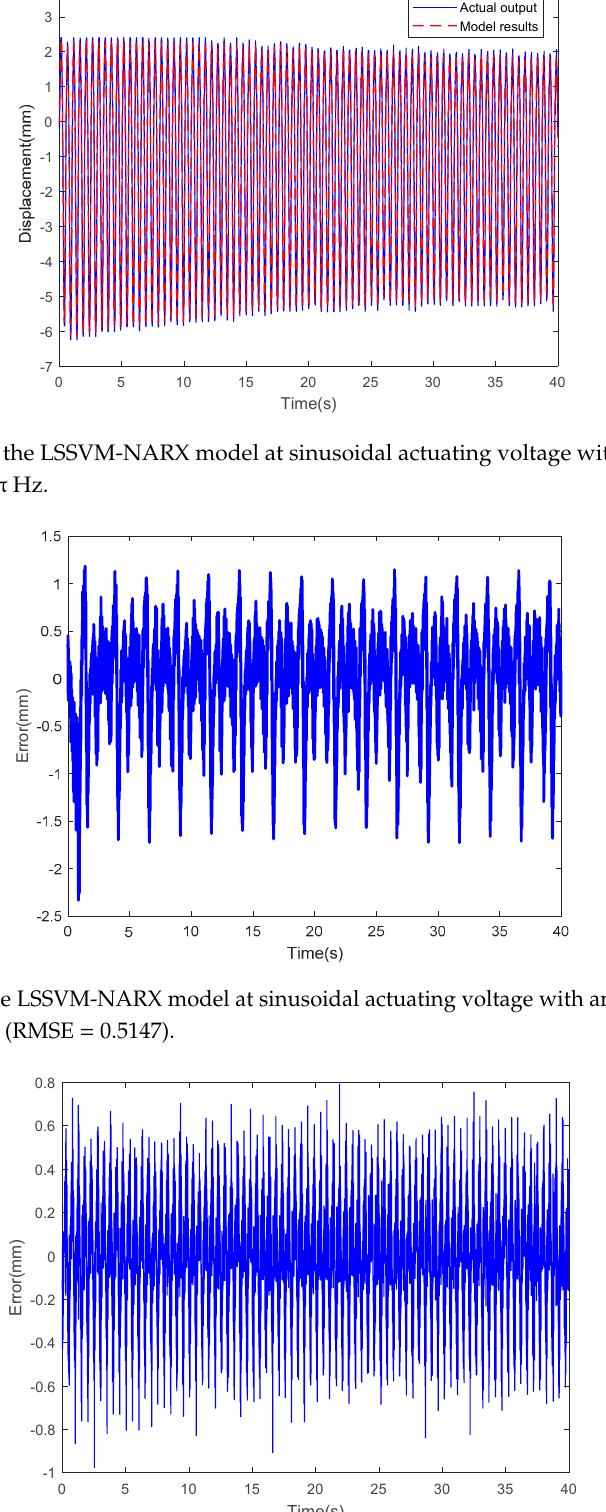
Figure 24. Error of the LSSVM ‐ NARX model at sinusoidal actuating voltage with amplitude of 3V and frequency of 5/2 π Hz (RMSE = 0.3042).